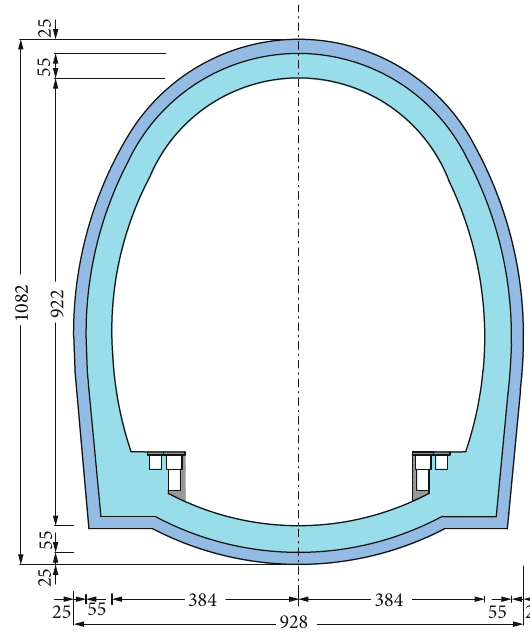
Figure 1: Horseshoe section of tunnel lining (units: